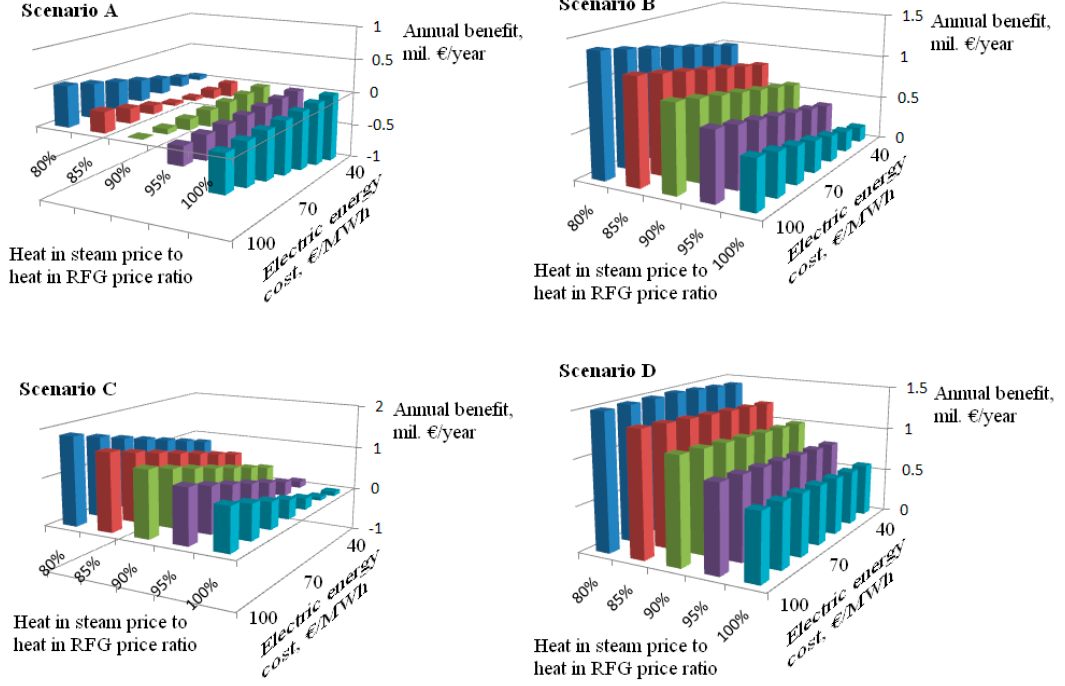
Figure 7. Benefit sensitivity to key economic variables; base case definition: c RFG = € 7 / GJ, c CO2 = € 10 / t, c CHTW = € 0.6 / t. Scenarios A to D are defined in the Model scenarios subchapter.